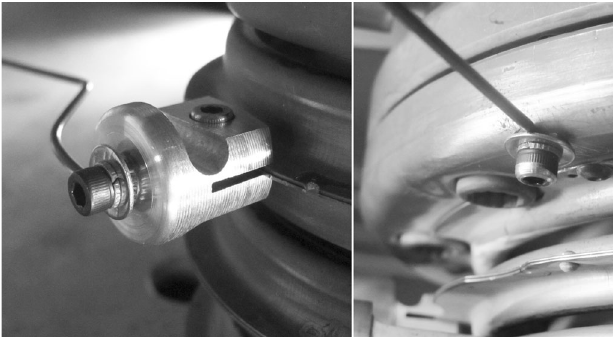
FIG. 13. New stringer: post mount using resistor clamp (left) and high-torque rounded hex head screw used to attach the stringer to tube